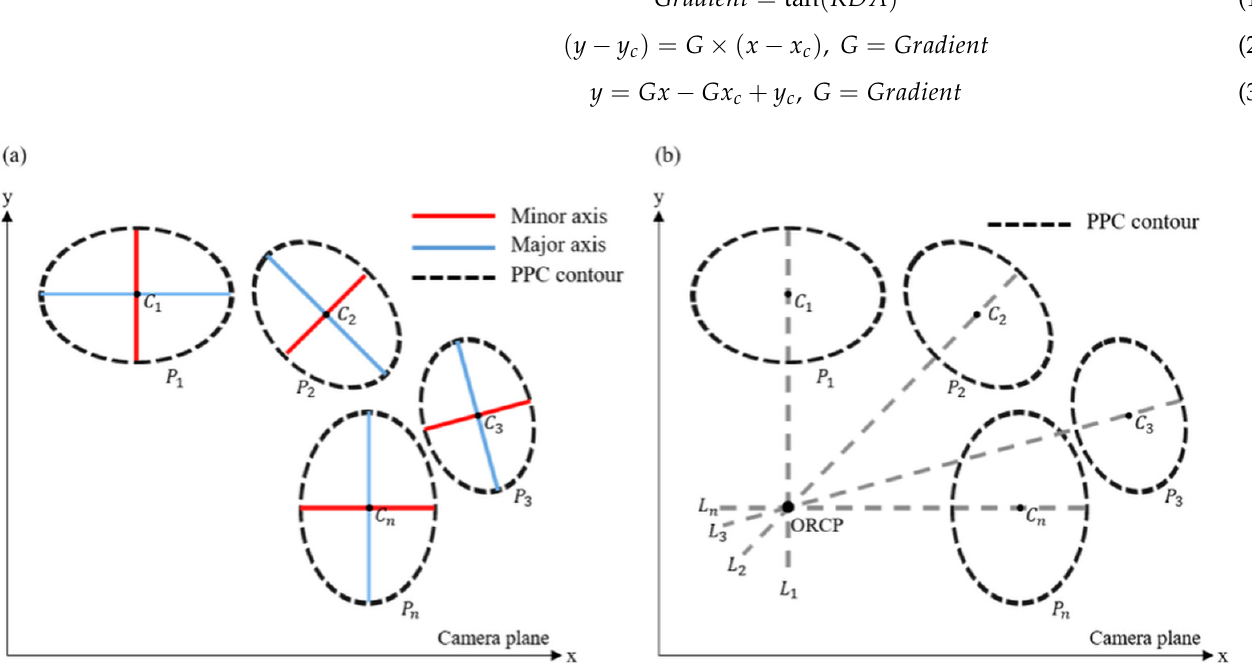
Figure 3. Conceptual diagram of ORCP inference method. ( a ) Obtained PPC data, ( b ) Straight line extracted from PPC.